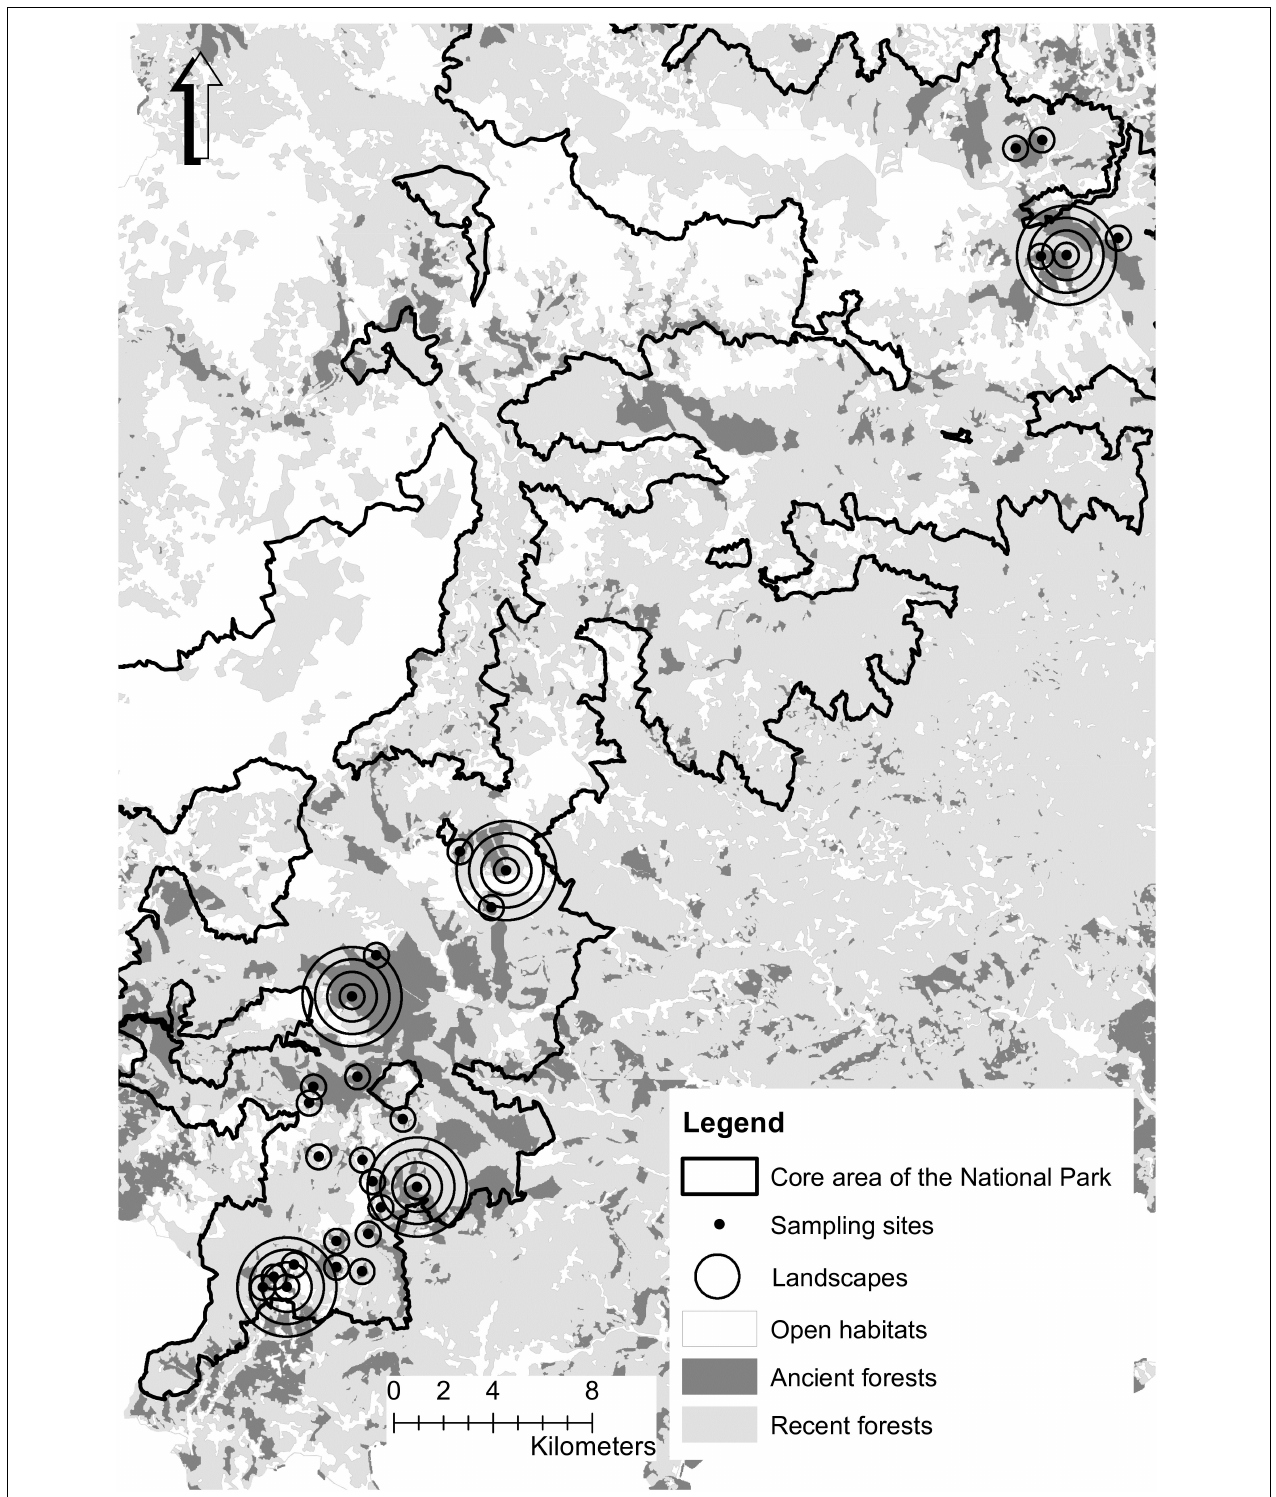
FIGURE 1 | Map of Cevennes National Park and distribution of ancient forests and sampling sites. Landscapes are illustrated as circles of different radii around sampling plots, but for more clarity, only radii of 500 m are drawn for most sites.